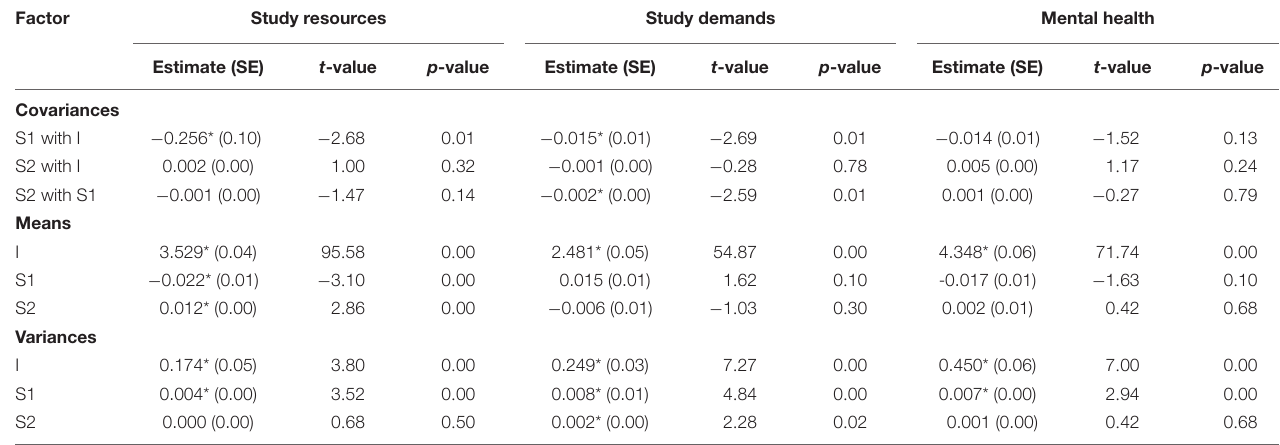
TABLE 5 | Unconditional piecewise latent growth model results: unstandardized estimates, means, variances, and t -values. Factor Study resources Study demands Mental health Estimate